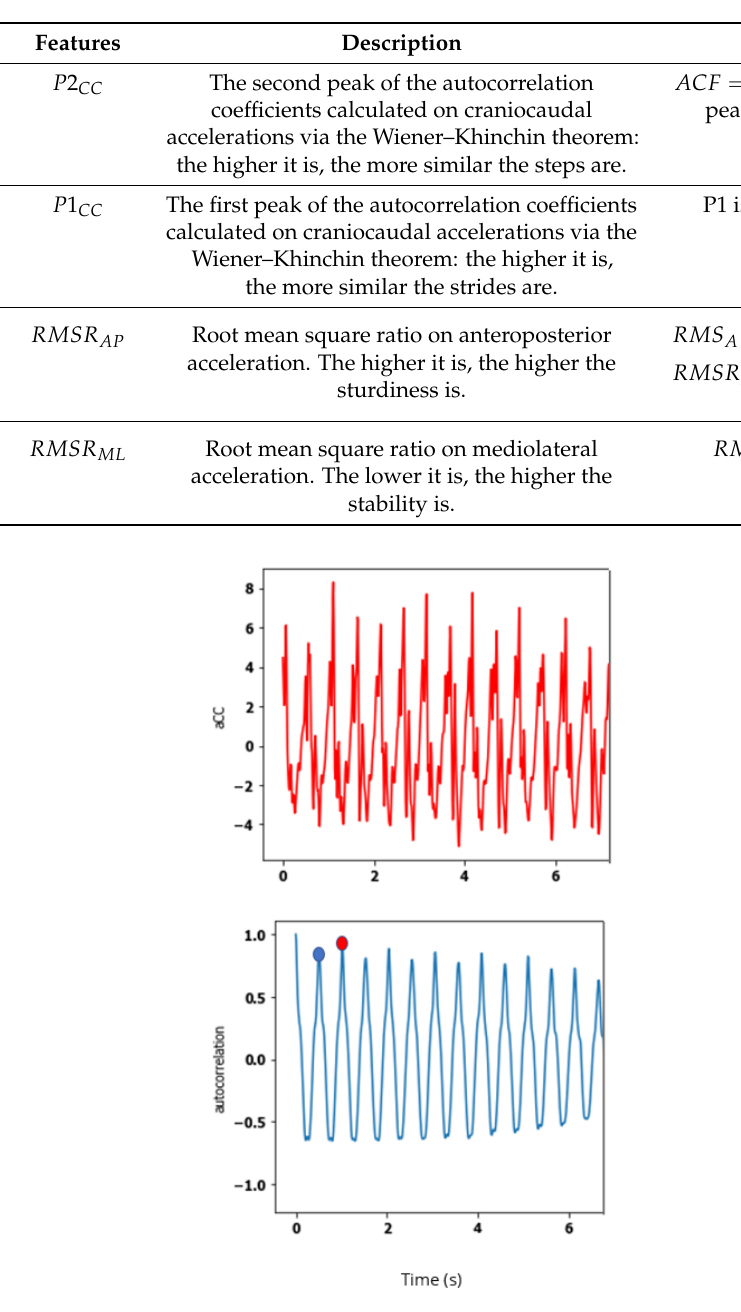
Table 3. Features used to establish scores for the graphical feedback. In total, four features are used. ConjFFT( X ) denotes the complex conjugate of FFT( X ).